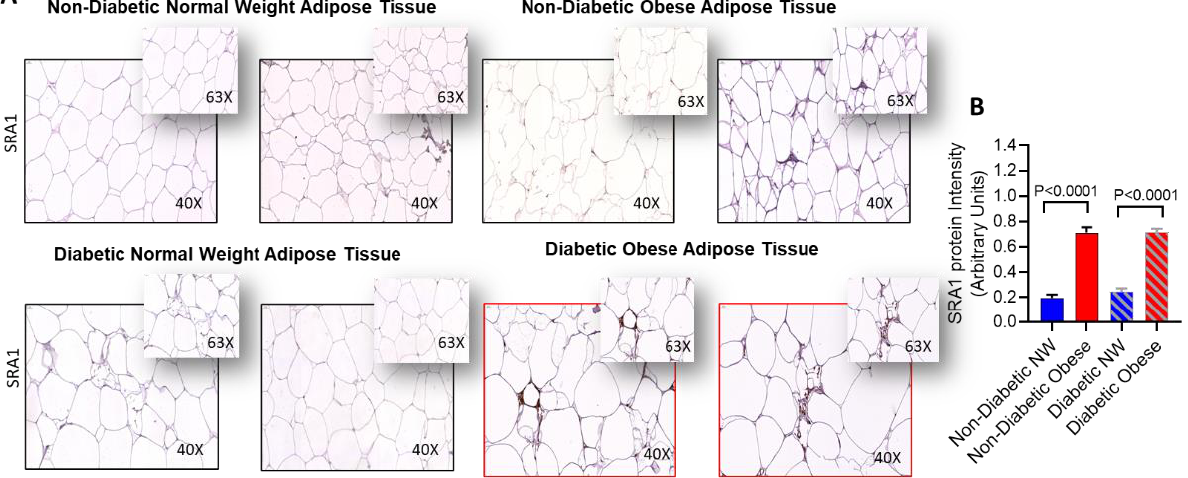
Figure 1. Adipose SRA1 protein expression in adipose tissue. SRA1 protein expression was deter- mined in adipose tissue samples from non-diabetic individuals with NW and obesity, as well as from persons with type-2 diabetic (T2D), as NW and those with obesity, 10 each, using by immunohisto- chemistry (IHC) as described in Materials and Methods. IHC staining intensity was expressed as arbitrary units (AU) and the data (mean ± SEM) were compared between NW and obese popula- tions, with or without T2D, using unpaired t -test and p < 0.05 was considered significant. ( A ) The representative IHC images are shown for non-diabetic NW/obese and T2D NW/obese individuals, one each. ( B ) IHC staining data (AU) show the elevated adipose SRA1 expression in persons with obesity compared to NW persons, whether with or without T2D ( p < 0.0001).